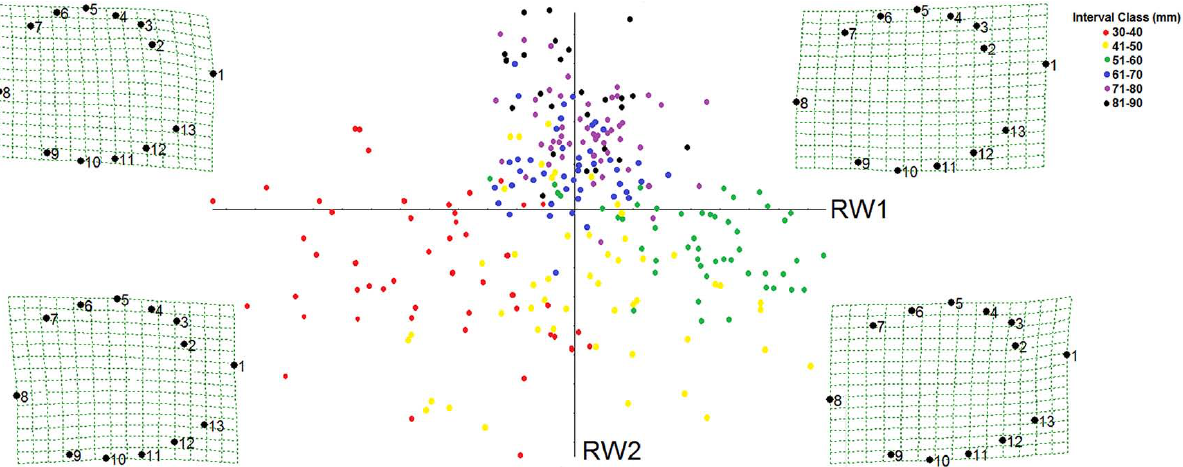
Fig. 7. – Thin-plate splines are represented near the position of the groups on the relative warps 1-2 ordination plot of the otolith shape of Anchoa tricolor